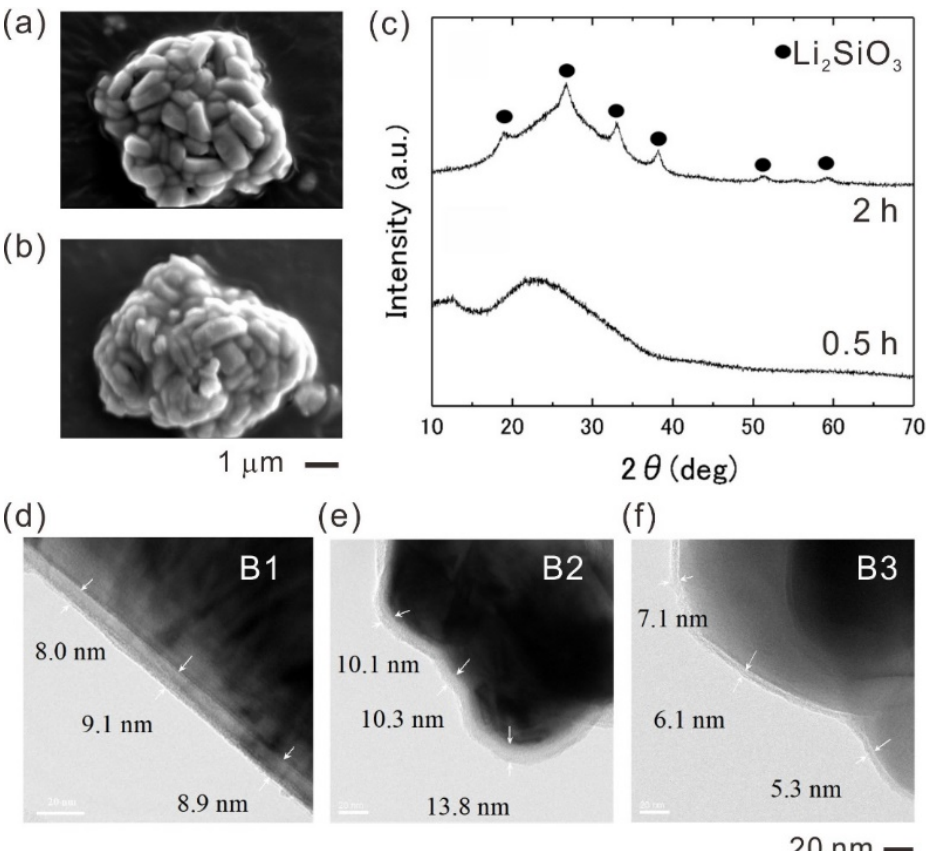
Figure 2. SEM images of the ( a ) pristine NMC and ( b ) LS-coated NMC particles. ( c ) X-ray diffraction (XRD) patterns of the lithium silicate at 350 °C. ( d – f ) TEM images of the LS-coated NMC particles from 3 batches.